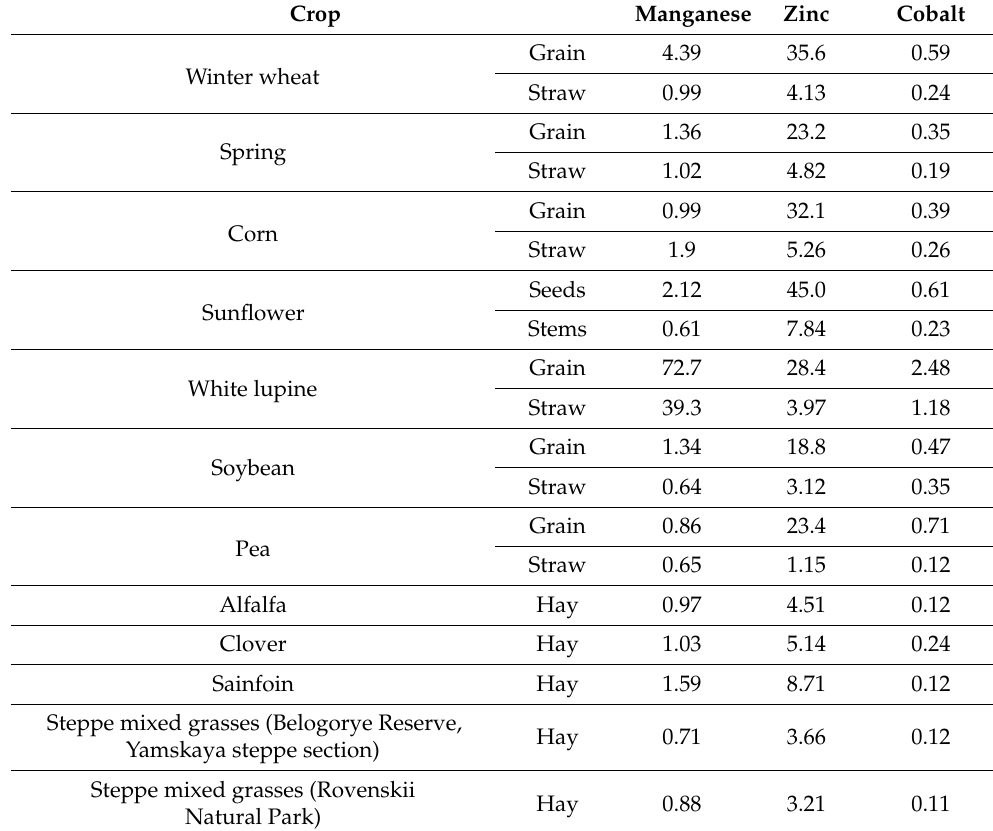
Table 7. Coefficients of biological adsorption of trace elements in plants, (mg/kg ash)/(mg/kg soil). Crop Manganese Zinc Cobalt Winter